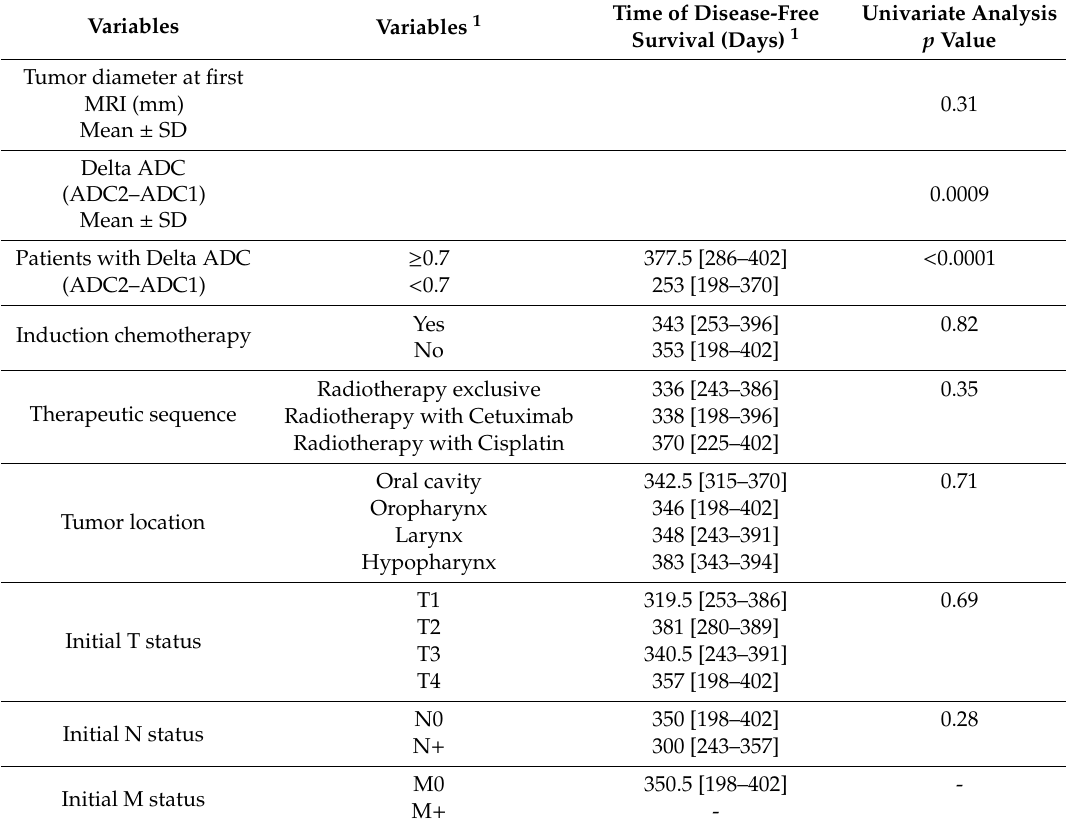
Table 3. Factors associated with progression or early recurrence after chemo-radiotherapy in univariate analysis.